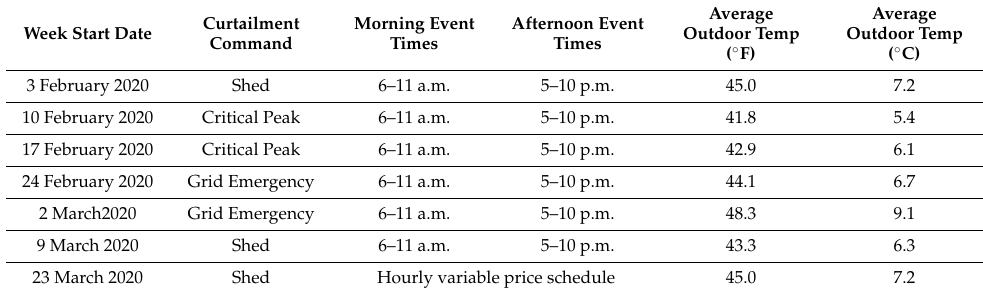
Table 4. “Smart” Strategy